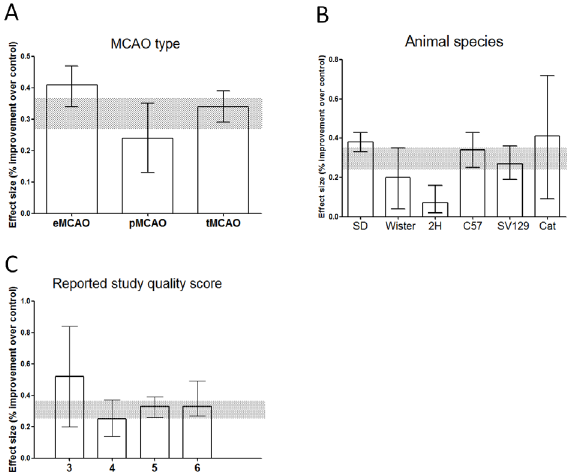
Fig 5. Point estimates and 95% CIs of effect size by: (A) MCAO type, (B) Animal species, (C) Reported study quality score. The 95% CI for the global estimate is shown as a grey band.